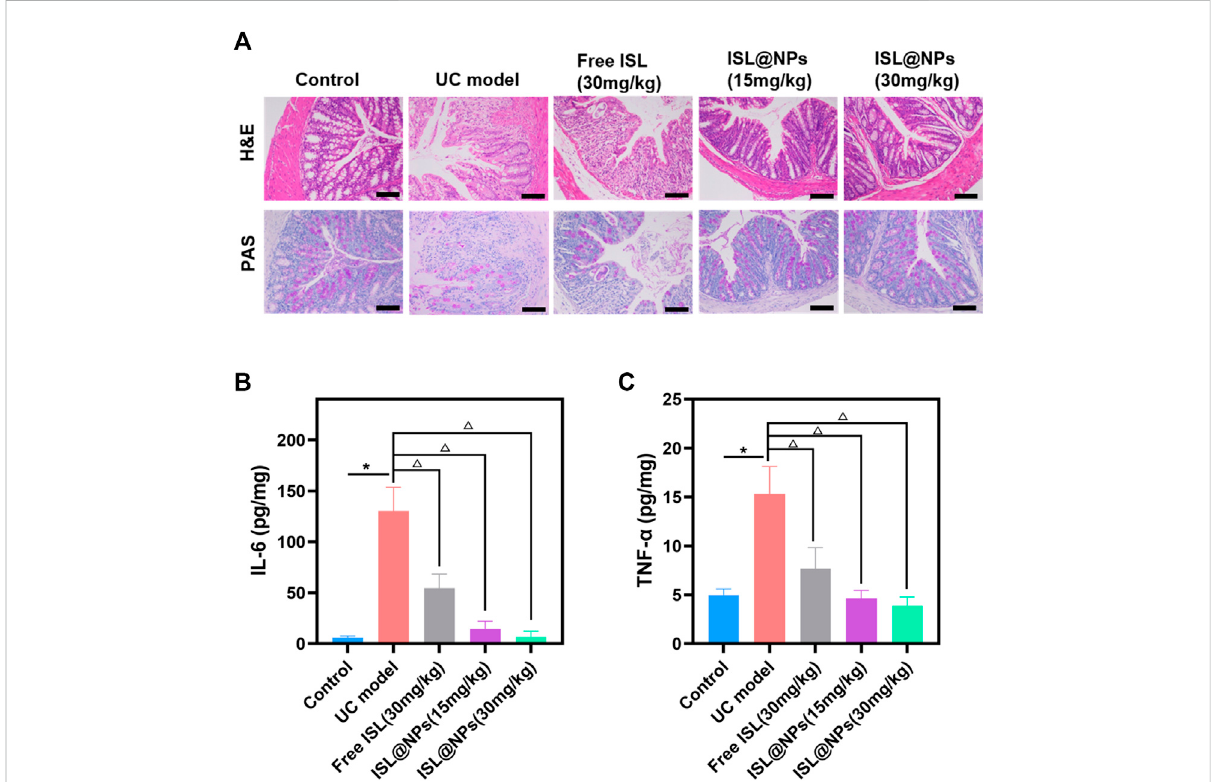
FIGURE 6 Histopathological evaluation and in fl ammatory factor determination. (A) Histopathological evaluation by H&E and PAS staining for different groups.Scalebar=100 μ m.ThelevelsofIL-6 (B) andTNF- α (C) incolontissueofmiceatday10.* p < 0.05(modelgroupvs.controlgroup), Δ p < 0.05 (model group vs. free ISL and ISL@NPs